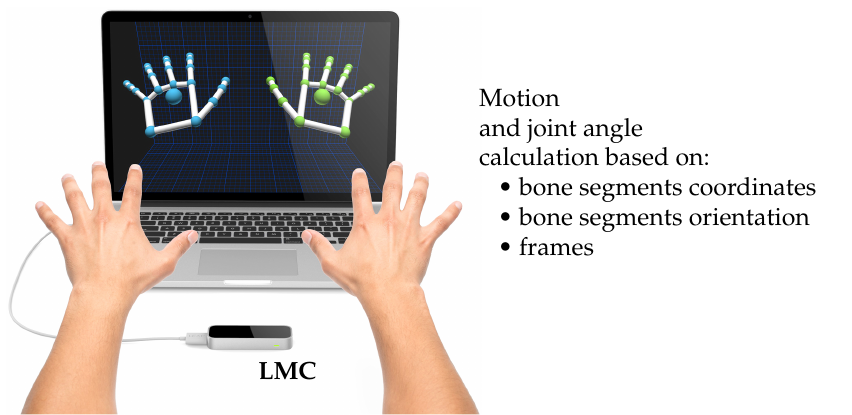
Figure 3. Recording the hand motion with a LMC. The LMC software visualizes the finger bones and joints of the internal hand model—marked on the screen as green and blue dots. The software ROSE Motion processes the LMC data and saves frames with motion data while recording, e.g., bone segments coordinates and bone segments orientation (source of image: the work in